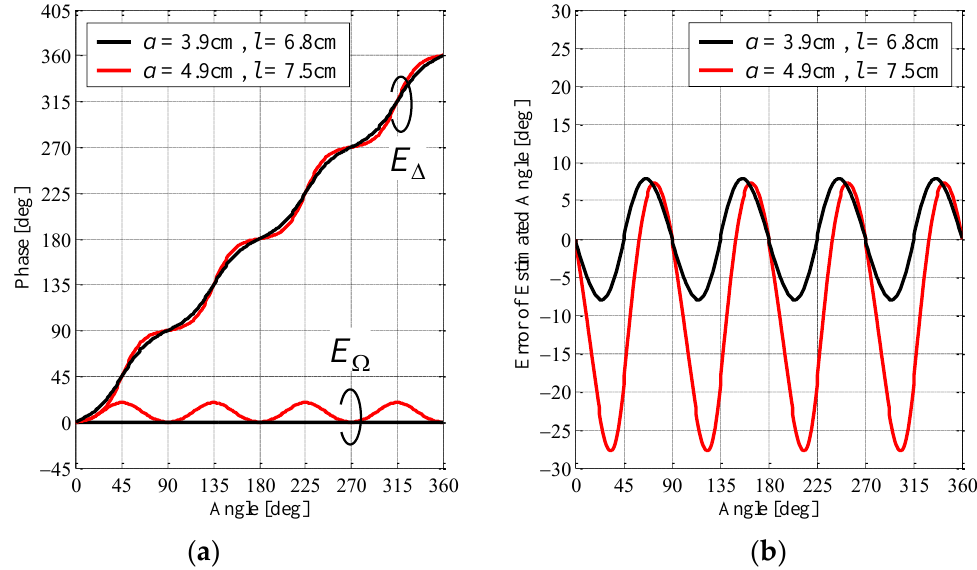
Figure 7. Analytical results of the angle estimated by the proposed antenna: ( a ) phase characteristics and ( b ) estimation error.